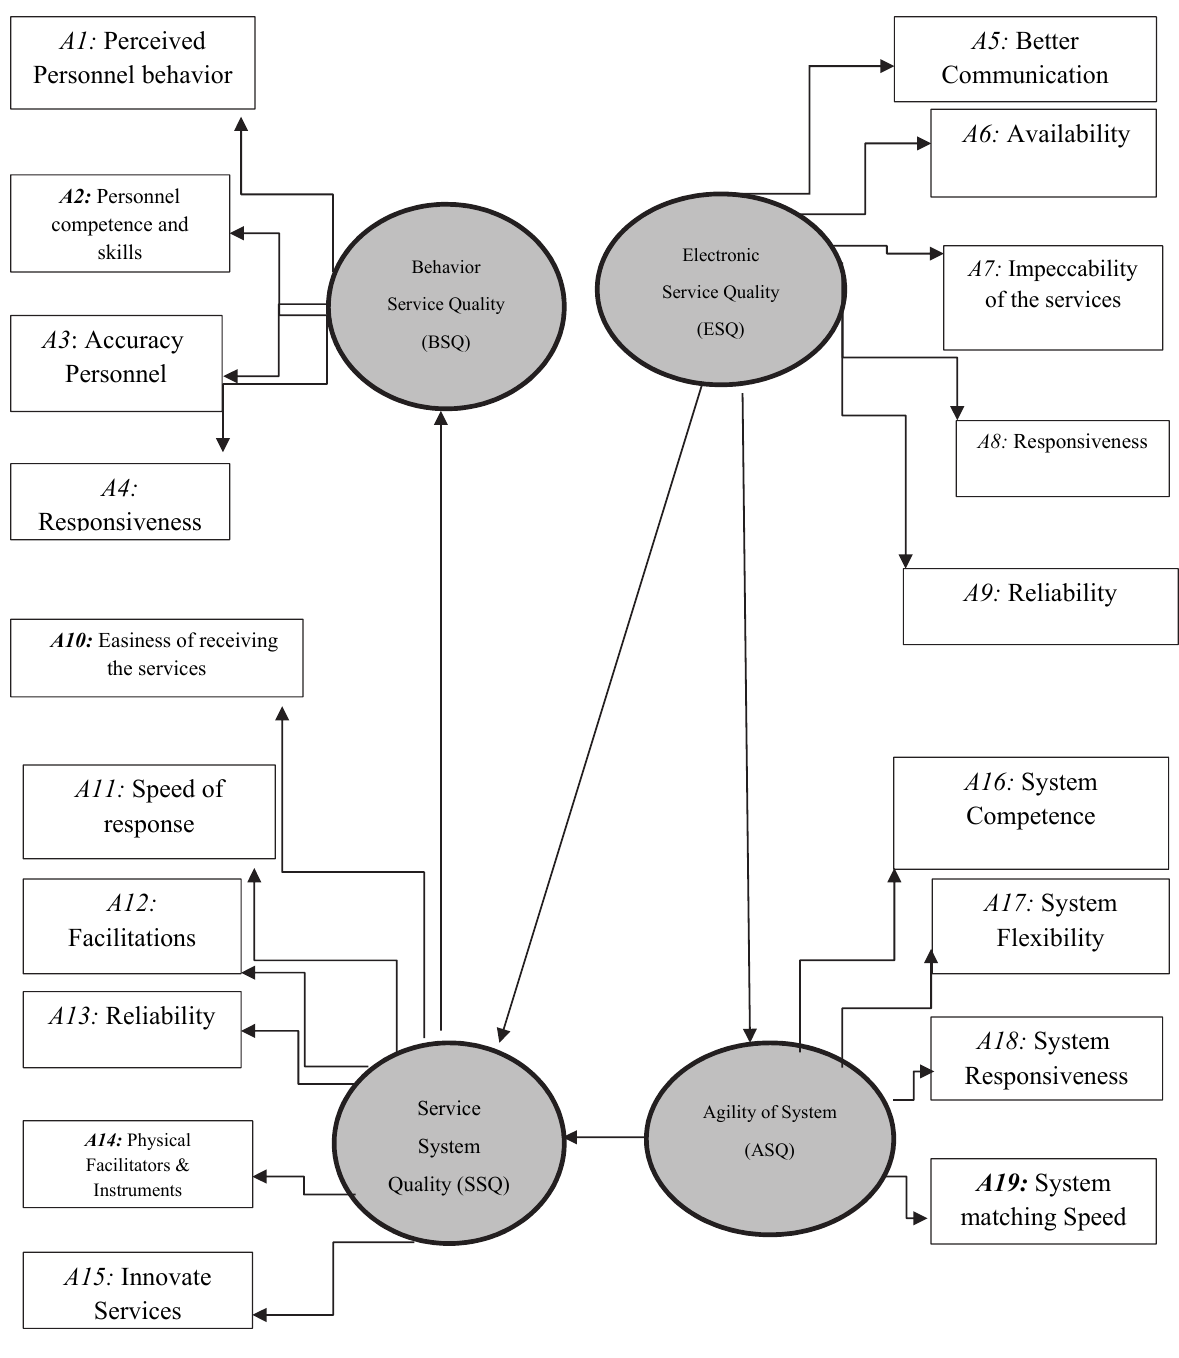
Fig. 1. Conceptual model: the relationship between the quality of electronic services and the agility of the